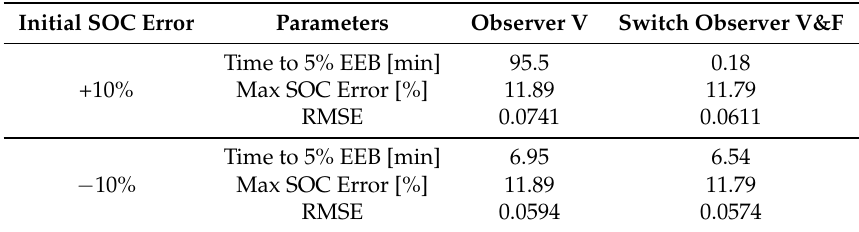
Table 6. Comparison of the RMSE index for different initial estimate error and different sensors for data validation. V, terminal voltage; V&F Bias, fusion of both sensors.